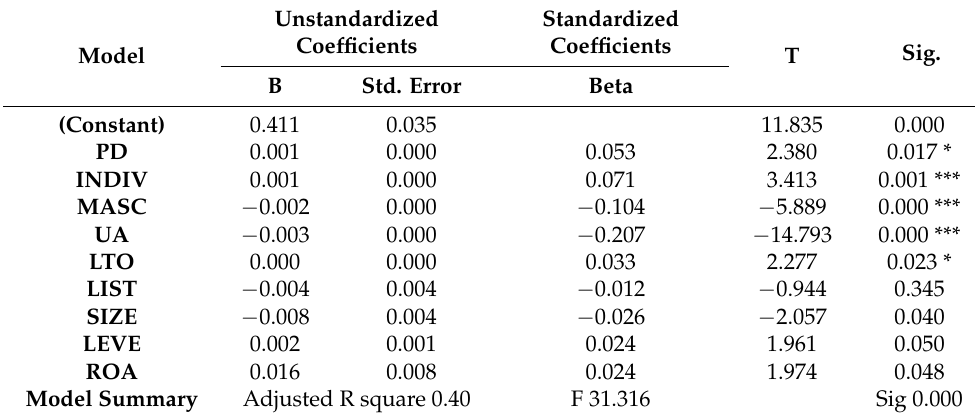
Model Summary Adjusted R square